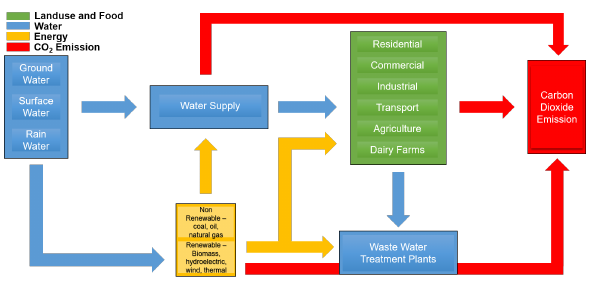
Figure 1. An urban FWE nexus conceptual